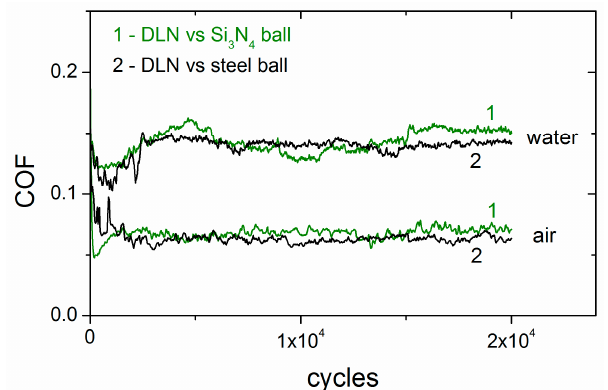
Figure 2. Friction performance of the DLN films during sliding against 100Cr6 steel and Si 3 N 4 balls in ambient air (RH = 50%) and distilled water; the load 0.5 N, the sliding speed 5 cm/s.